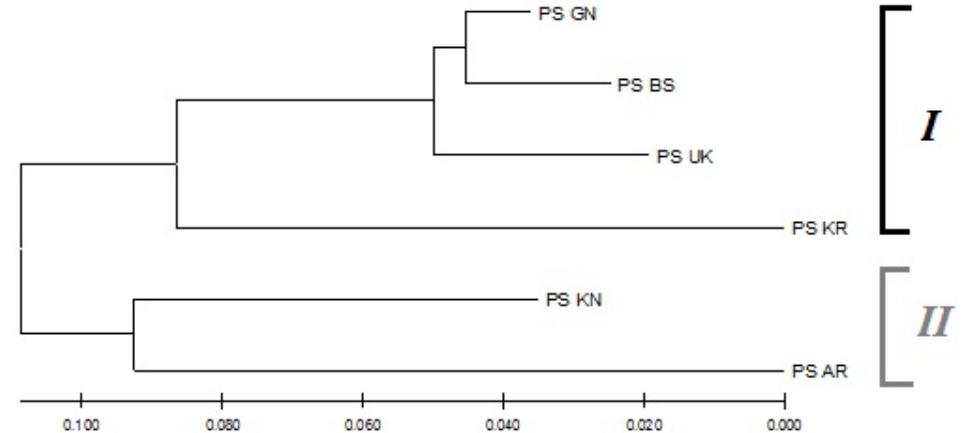
Figure 2. Dendrogram of genetic similarity of six studied populations of P. sylvestris, built based on polymorphism of ISSR profiles by neighbor-joining method (I, II - cluster numbers).